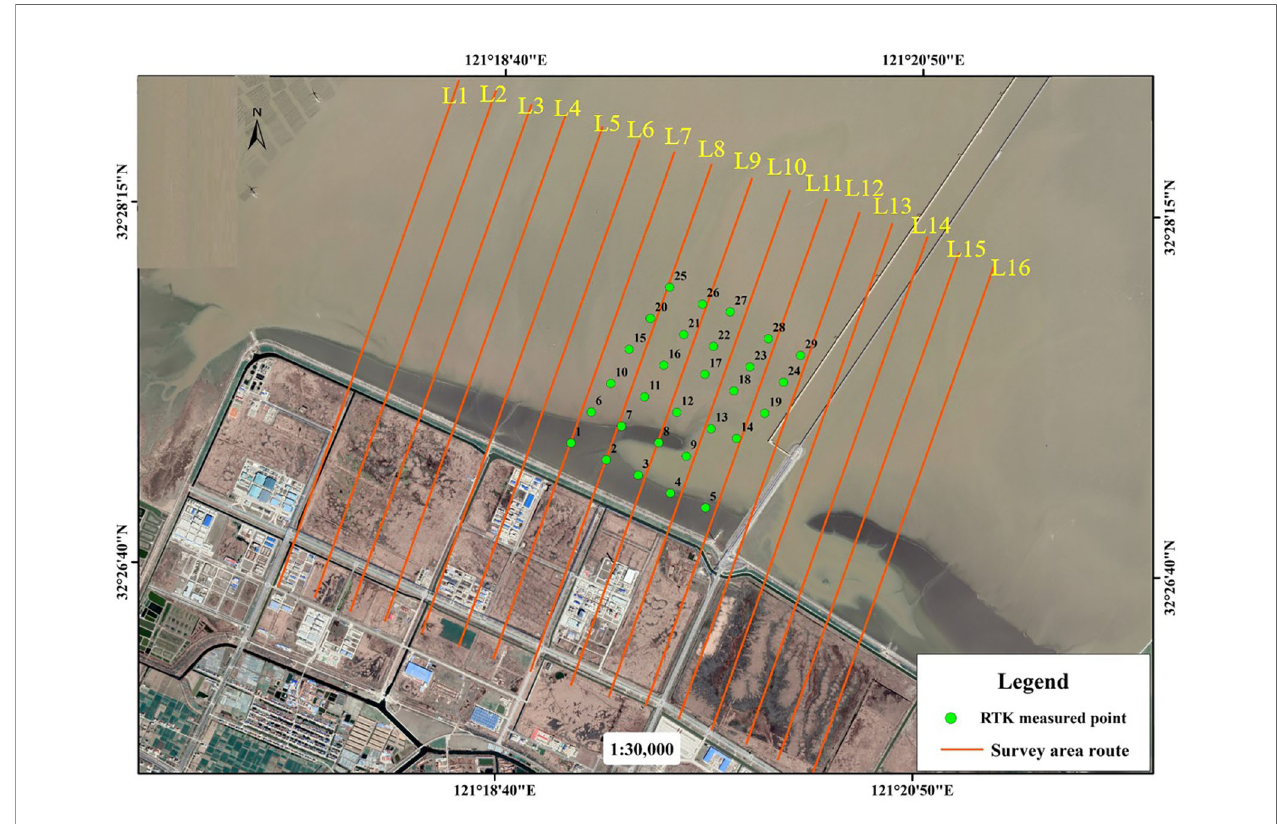
FIGURE 2 | The Monitoring area and GPS-RTK